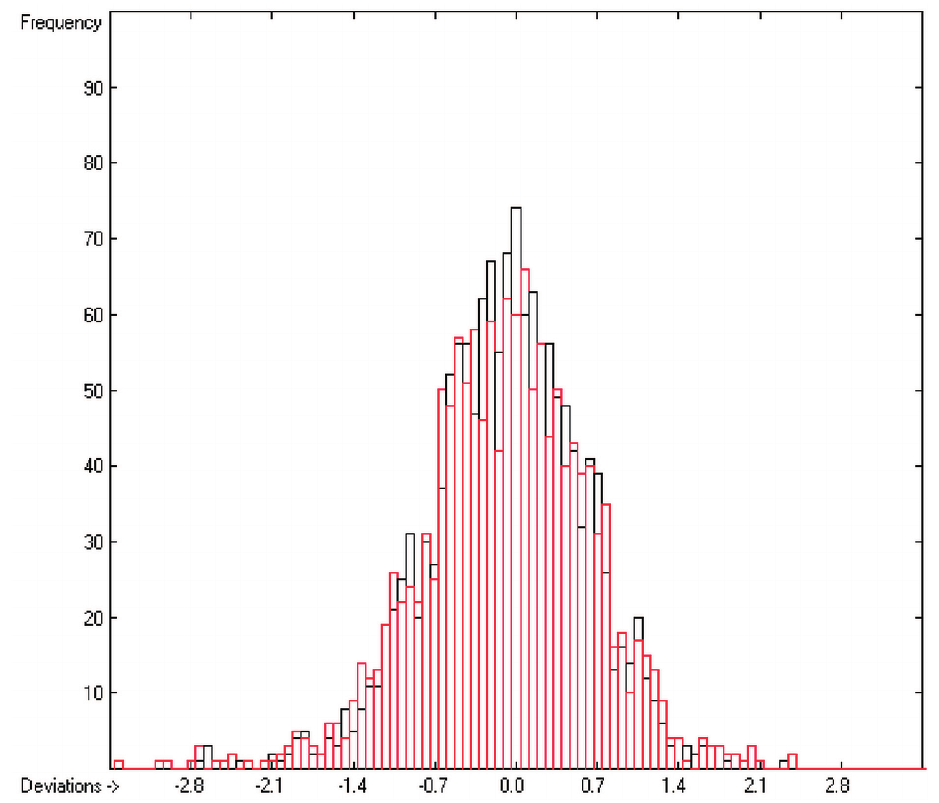
Figure 9. Histogram of logS data (S =